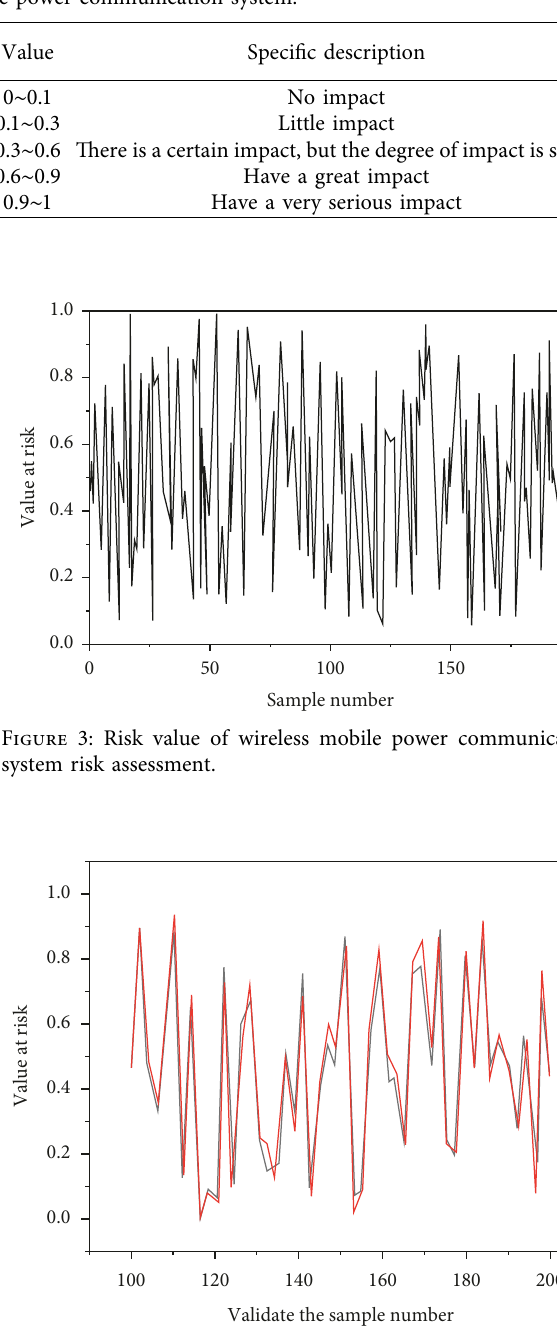
Table 1: Risk level of wireless mobile power communication system.